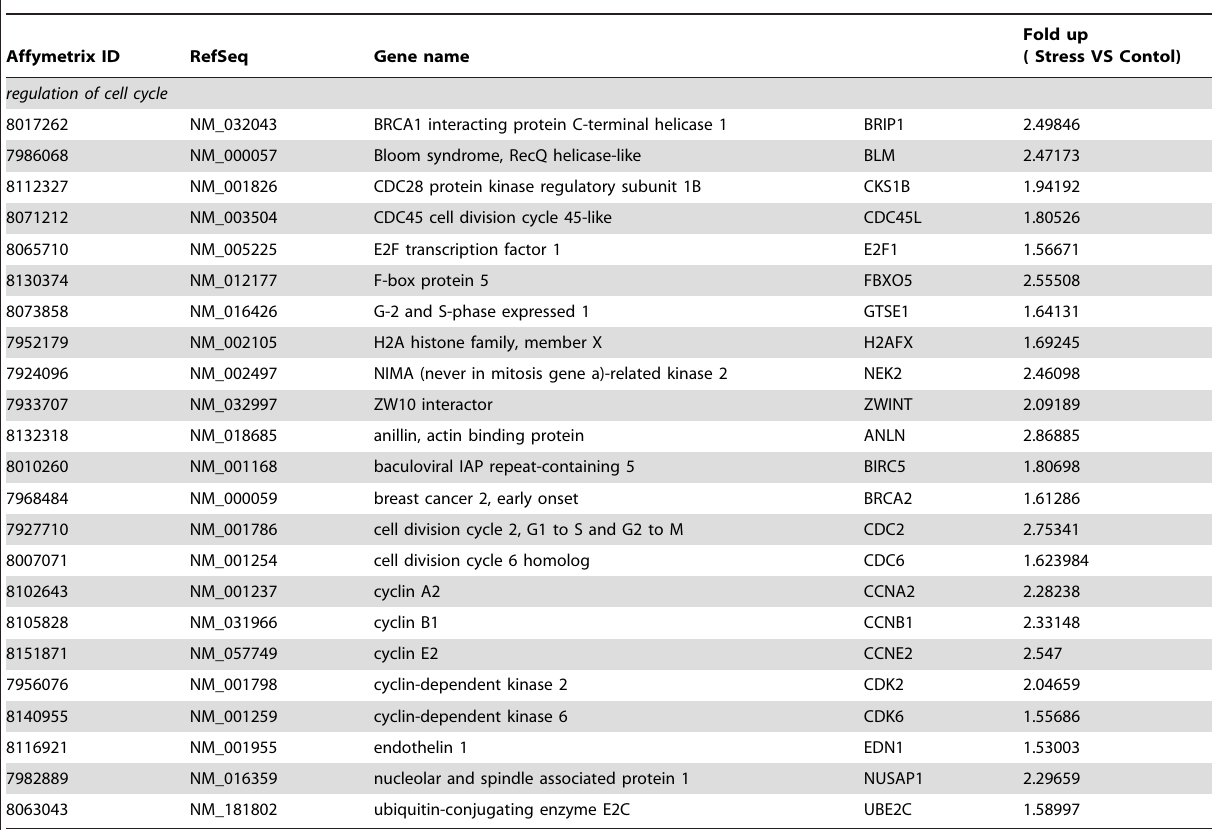
Table 1. Cluster analysis of mRNA (out of 453 total) induced more than 1.5-fold by mechanical stress. Average expression value is shown. (P ,